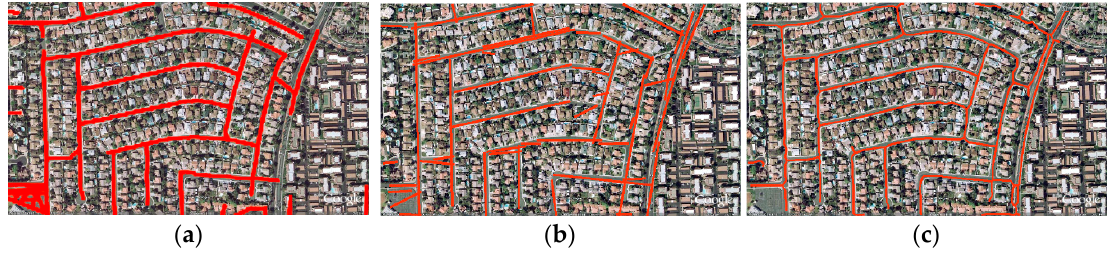
Figure 8. Road extraction results of the second study area: ( a ) result of Poullis 2014 (adapted from [12]); ( b ) result of Poullis 2010 (adapted from [12]); ( c ) result of proposed method.